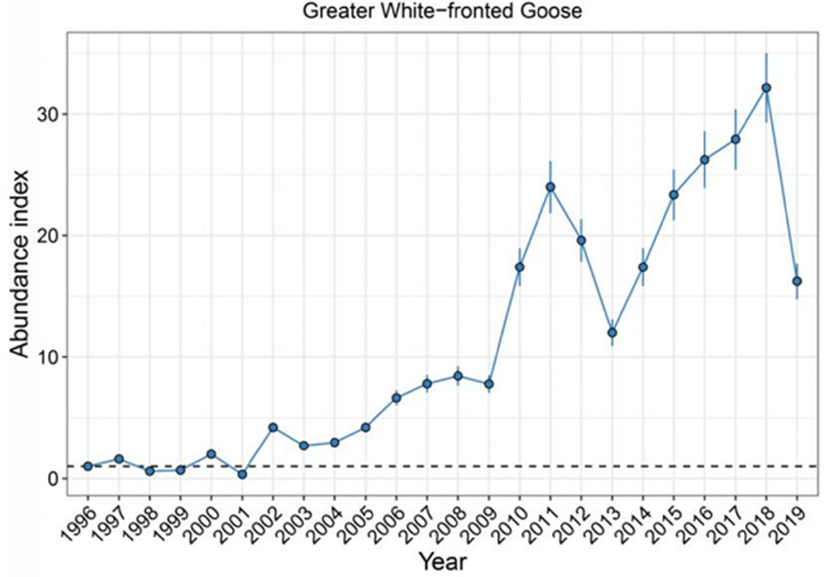
Figure 2. Changes of the population trend for the Greater White-Fronted Goose in the past two decades at Shengjin Lake National Reserve in the Yangtze River Floodplain. Error bars indicate the 95% CI.